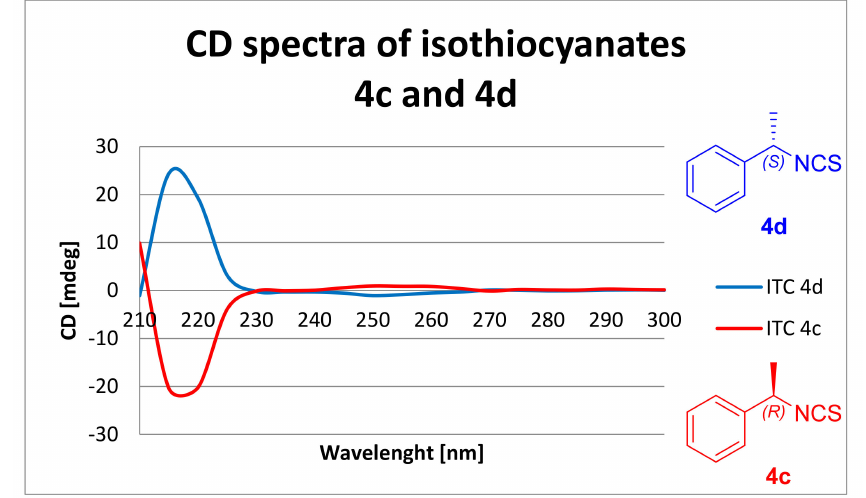
Figure 8. CD spectra of ITCs 4c and 4d